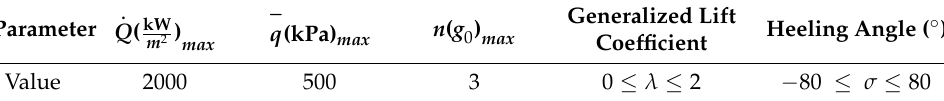
Table 2. Process constraints of trajectory